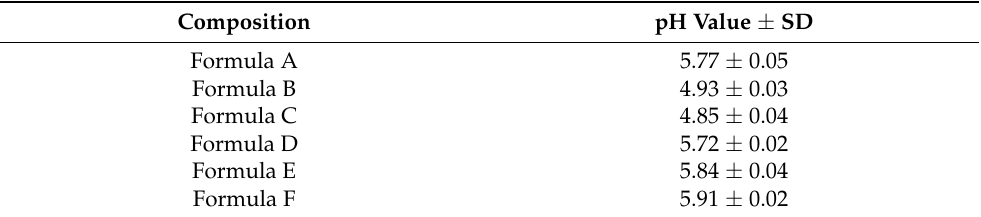
Table 2. The pH values of the compositions. Each data point represents the mean ± S.D., n =